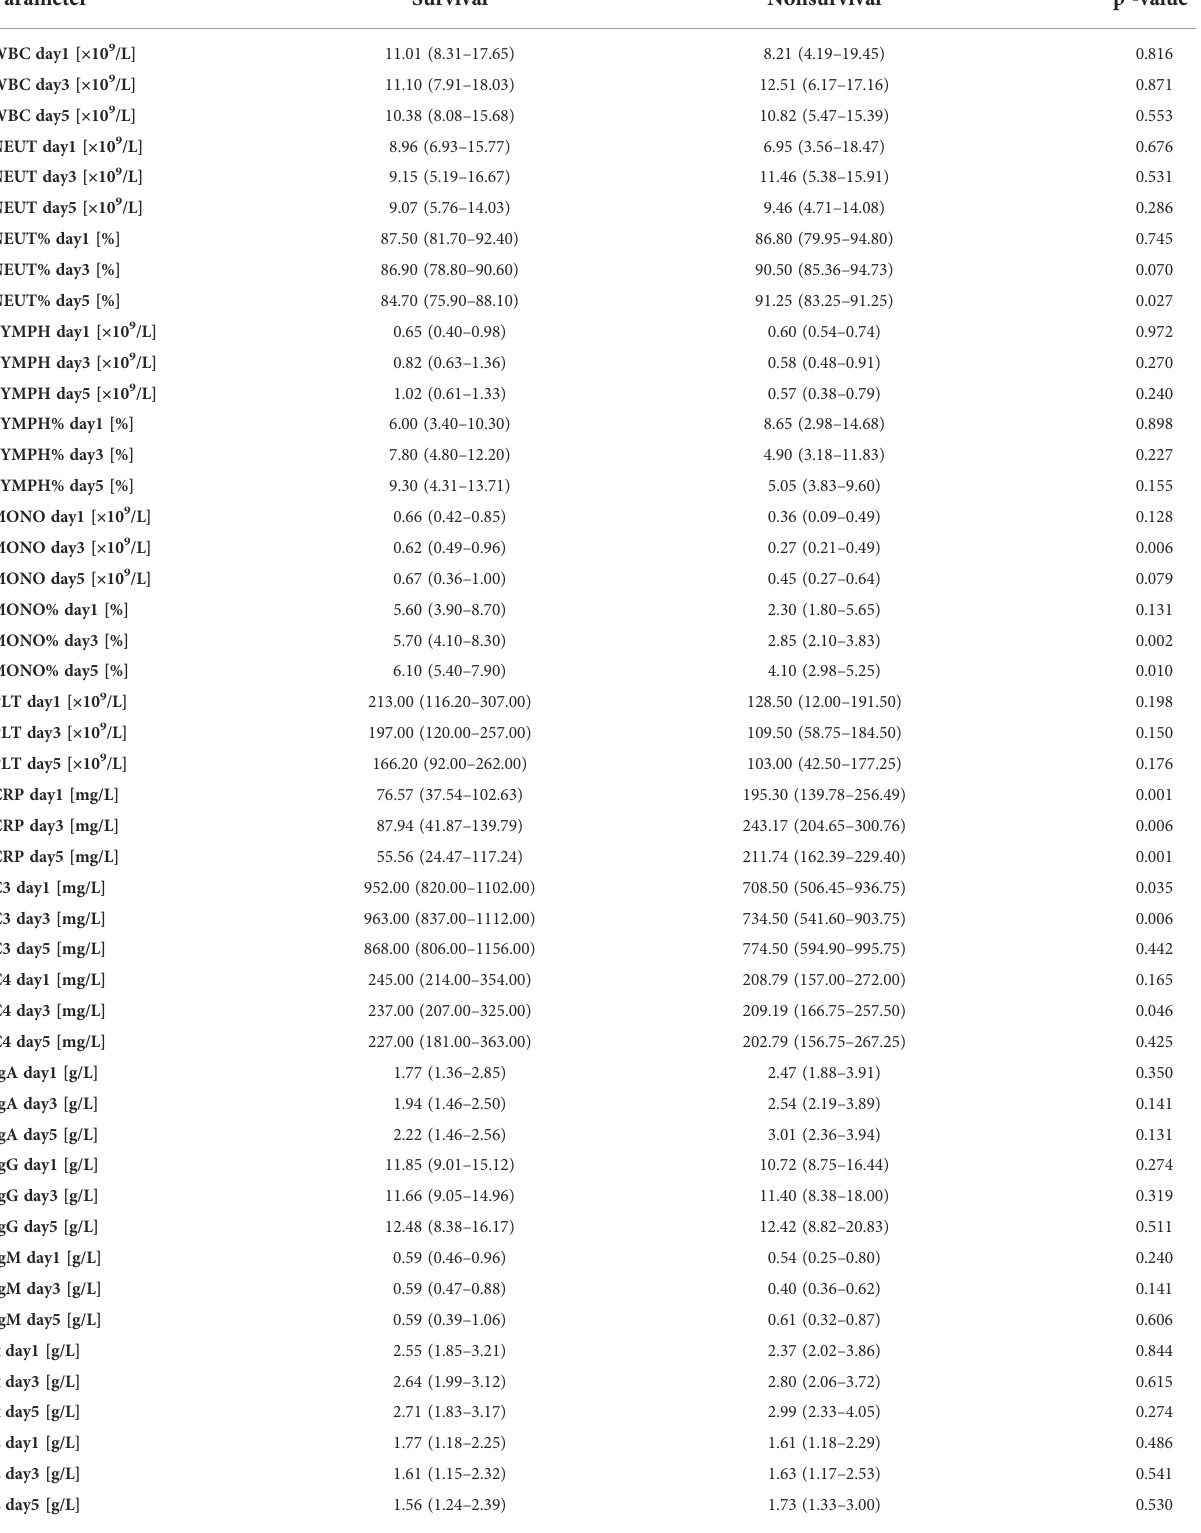
TABLE 2 Clinical and immune related biochemical data of nonsurvivors and survivors in examinational cohort.